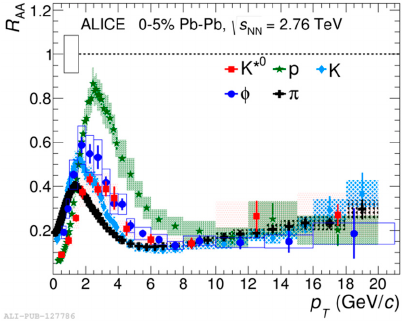
Figure 8. The R AA of K*(892) 0 and φ (1020) as a function of p T in the 0–5% Pb-Pb collisions at √𝒔 𝐍𝐍 = 2.76 TeV. The statistical and systematic uncertainties are shown as bars and boxes, respectively. Figure taken from [10]. Figure taken from